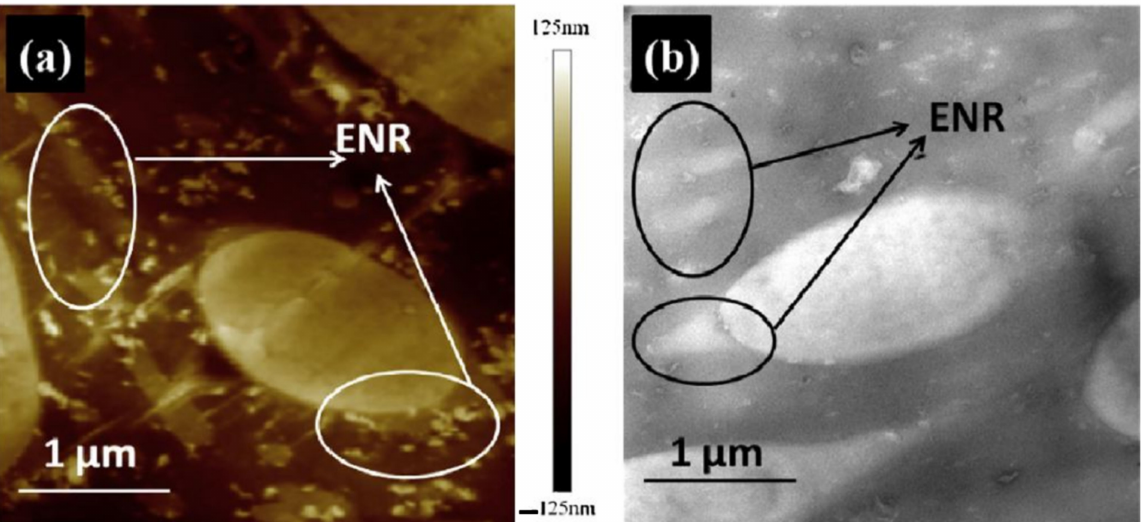
Figure 11. ( a ) AFM height image and ( b ) TEM micrograph of NR/NBR/ENR25 (70/30/15) composite [32].